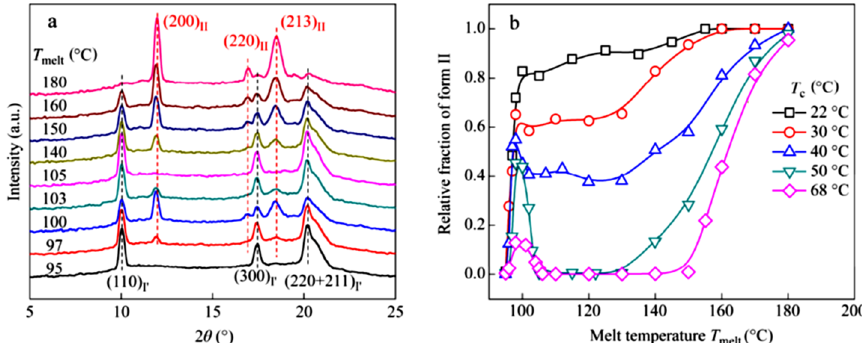
Figure 9. ( a ) Selected WAXD curves of a butene-1/ethylene random copolymer with 9.88 mol % ethylene co-unit crystallized isothermally at 50 °C after melting at different temperatures as indicated in the left column. ( b ) The relationship between the relative amount of form II crystals crystallized at different temperatures as indicated in the right column and the melting temperature during sample preparation. Reproduced with permission from Ref. [74], copyright 2016 Chinese Chemical Society.